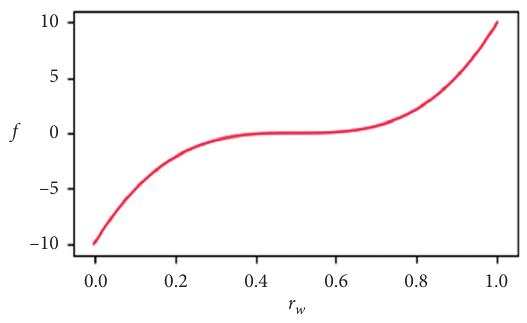
Figure 3: The curve of function